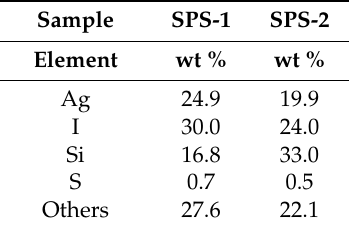
Table 2. Composition of the SFA SPS samples based on the initial composition of the SFA material. The “Others” is comprised primarily of oxygen and minor species (e.g.,